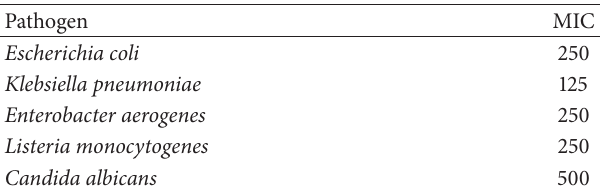
Table 2: Minimum inhibitory concentrations (MICs) (mg/mL) of Croton macrostachyus EtOAc extract against selected human